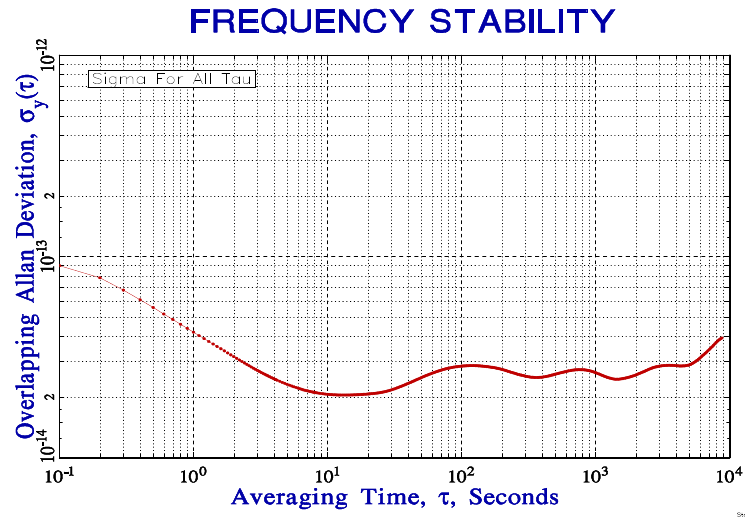
Figure 4. Measurement of the relative frequency stability (Allan deviation) of frequency-tripled fiber laser stabilized by “starved” type of borosilicate glass made iodine cell.